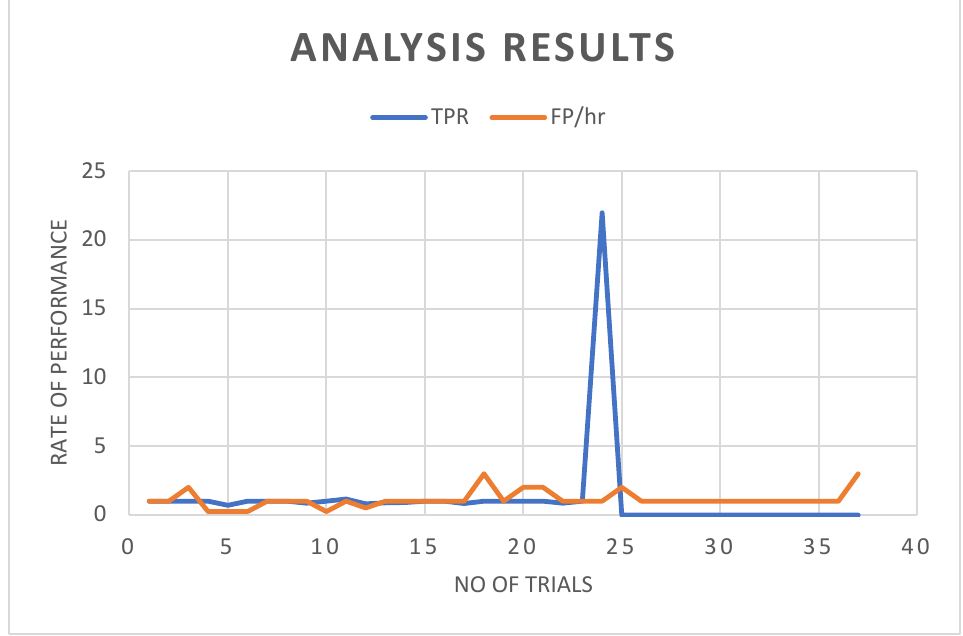
Figure 9. Time-based performance of the proposed algorithm: (TPR is total positive rate) and (FP/hour is false positives per hour. Note: The figure shows the total positive and false-positive rates per hour for all the individual trials of patient data. In the dataset, a single patient may have a varied number of 15 to 42 data files. Each data file is named according to the number of trials; that is, Patient 1 has 42 data files or trials.